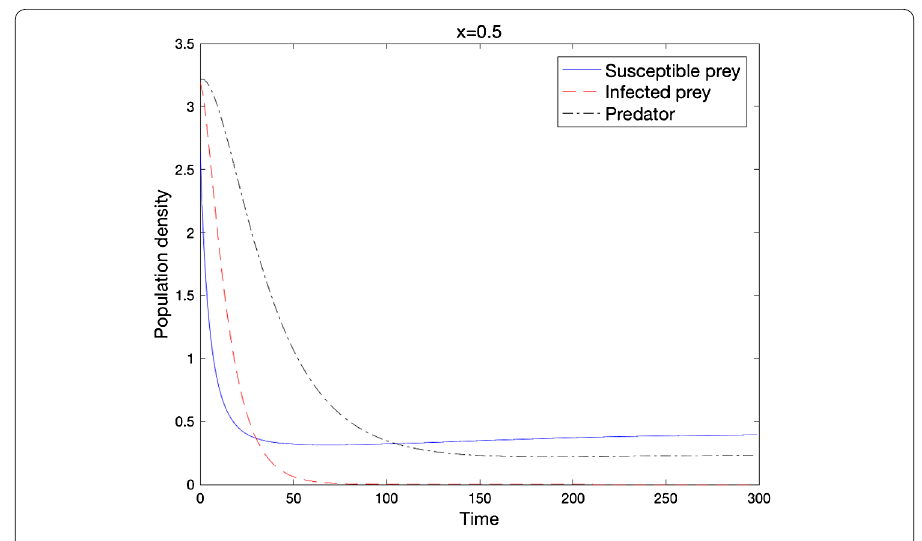
Figure 3 Local stability of e 2 when the condition of Theorem 2.7 holds ( d = 0.01, D = 0.01, r = 0.5, b = 0.430, d 1 = 1.0, d 2 = 0.5, K = 1.0, α = 3.5, β = α , c = 1.0, m = 10.0).